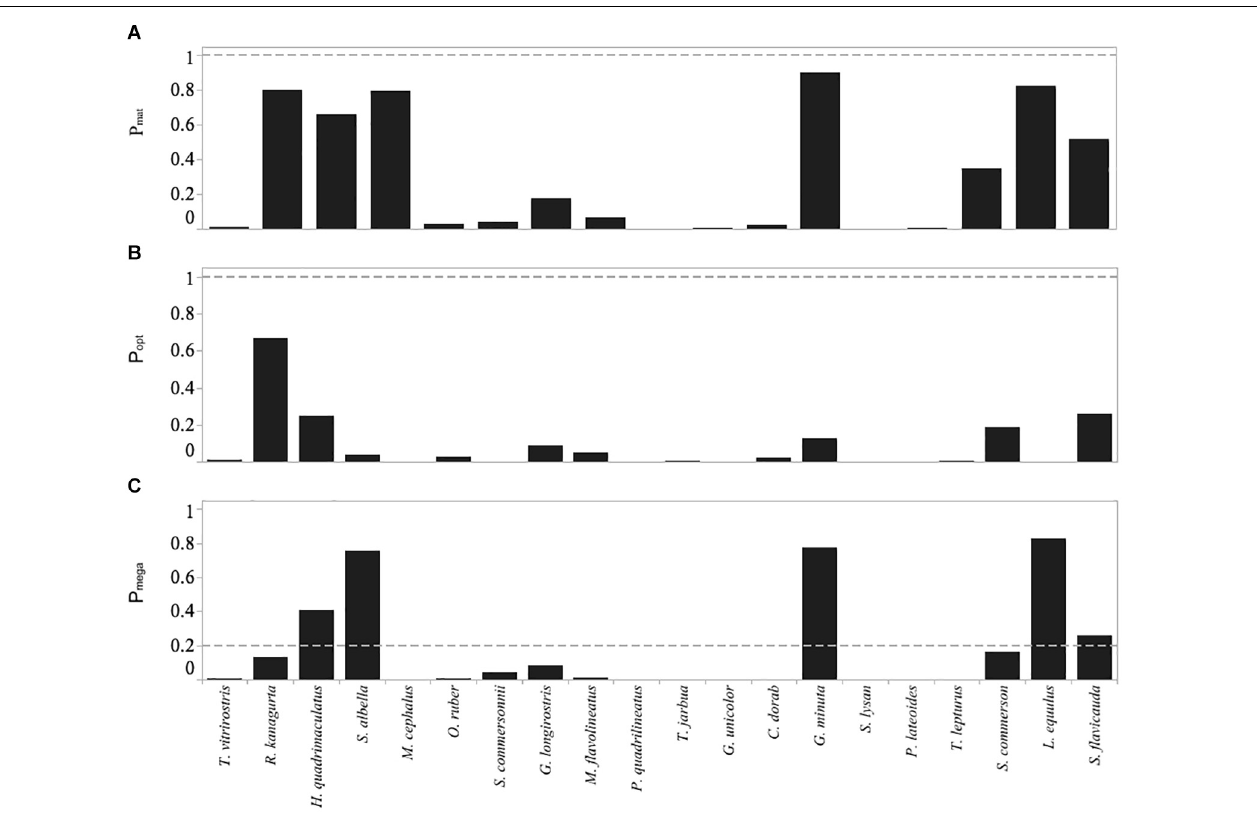
FIGURE 6 | Froese indicators for the top twenty most abundant species caught in the Menabe small-scale fishery, including (A) P mat the fraction of catch that is mature), (B) P opt the fraction within the optimal size range, and (C) P mega the fraction of megaspawners. Horizontal dashed lines are target levels of the indicators as suggested by Froese (2004) (below the dashed line is not